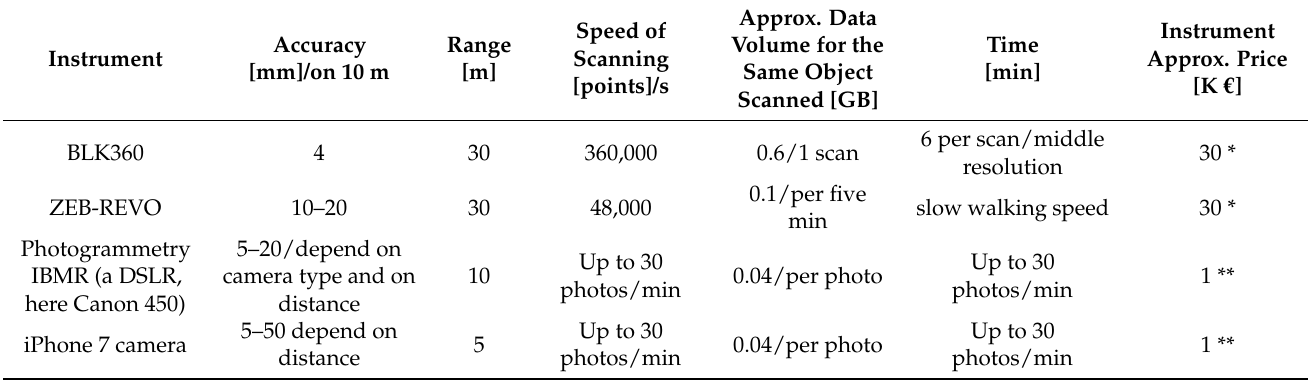
Table 2. Comparison of accuracy and economy of the process (* including software, ** without software price—we use the university license, which is only 0.6 K €